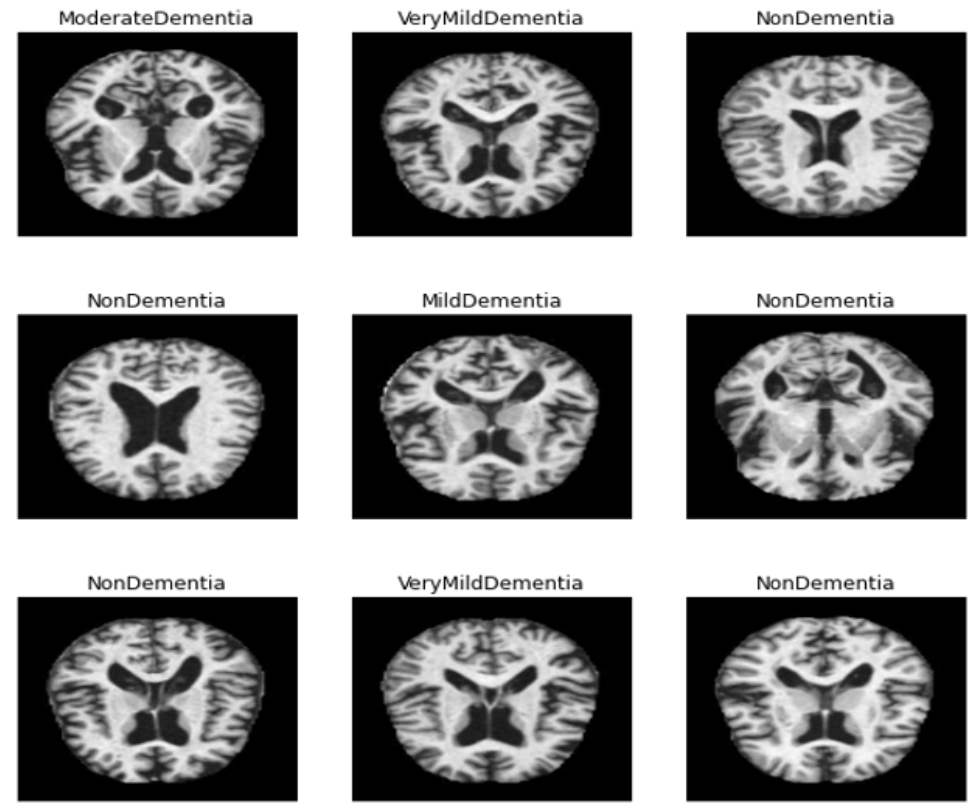
Figure 2. A sample of the MRI Alzheimer’s dataset.